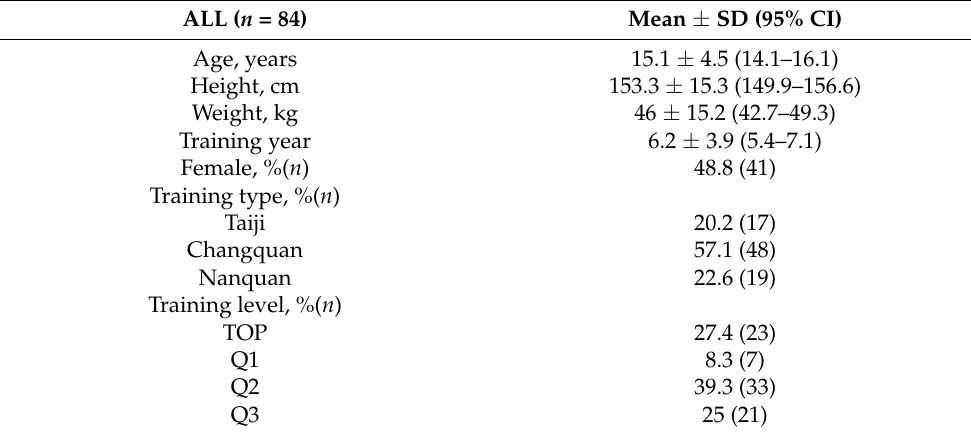
Table 1. Participants’ characteristics.